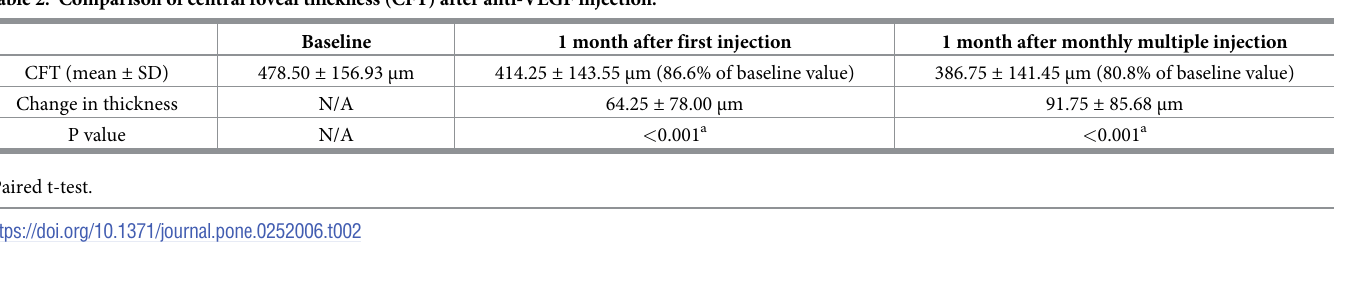
Table 2. Comparison of central foveal thickness (CFT) after anti-VEGF